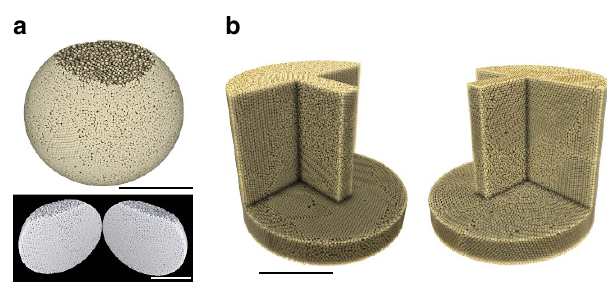
Figure 1 | 3D rendering of spherical and cylindrical experimental packings. Internal structure of partially crystallized packing with a global packing density of f ¼ 0.685 in ( a ) a spherical container and ( b ) a cylindrical container. The scale bar length is E 25mm. In ( a ), the spherical packing contains 80,000 beads. In panel ( b ), two different 3D sections of a cylindrical packing made of 200,000 beads. Panel ( b ) highlights the heteregeneous structure of our packings composed of both random and highly crystalline clusters. By comparing the two 3D sections, it also shows that the rich polycrystalline structures of our packings are characterized by defects, such as grain vacancies and dislocations.